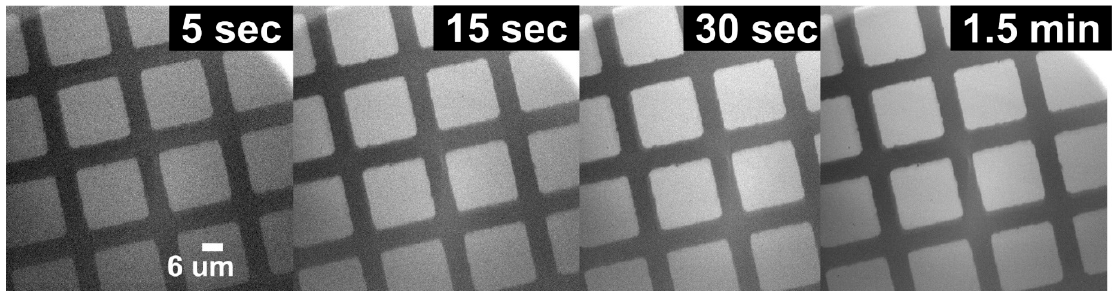
Figure 5. Comparison of soft X-ray images of copper mesh (1000 lines/inch) with different exposure times. The scale bar is 6 µm and is the same for each image.